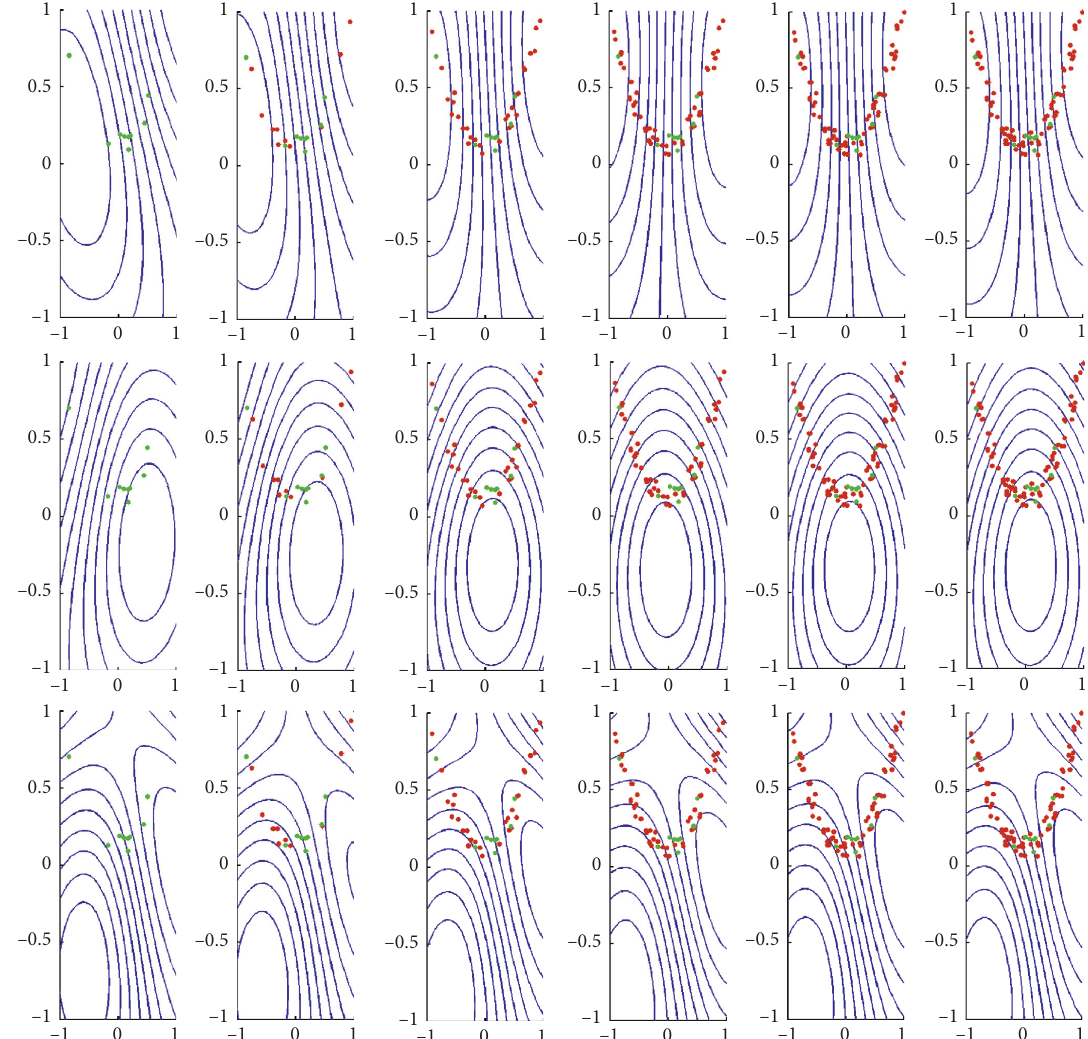
Figure 2: Two-dimensional examples by IMKPCA. The first and sixth columns: original input data and the total sample. From the second to the fourth column: the result of update processes. From top to bottom: the projection value onto the first three kernels principal